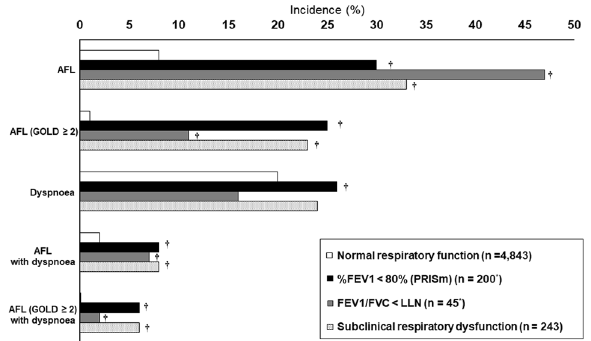
Figure 2. Incidence of the development of AFL, dyspnoea and both among subjects who underwent follow-up assessment. Incidence rates of AFL, dyspnoea, and both (AFL with dyspnoea) at follow-up in groups with normal respiratory function and subclinical respiratory dysfunction at enrolment (N = 5086). A GOLD grade ≥ 2 was defined as the development AFL with %FEV1 < 80%. AFL airflow limitation, FEV 1 forced expiratory volume in 1 s, FVC forced vital capacity. *Two subjects had both FEV 1 /FVC < LLN and %FEV1 < 80% at baseline. † P value < 0.05 compared with normal respiratory function.